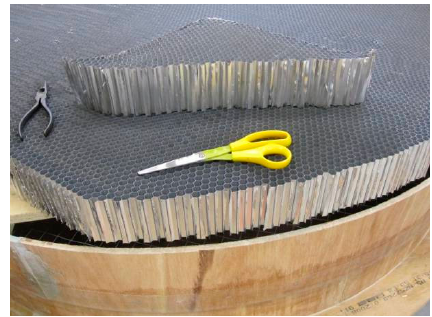
Figure 6. Honeycomb edge cut to match internal diameter of flow conditioner.